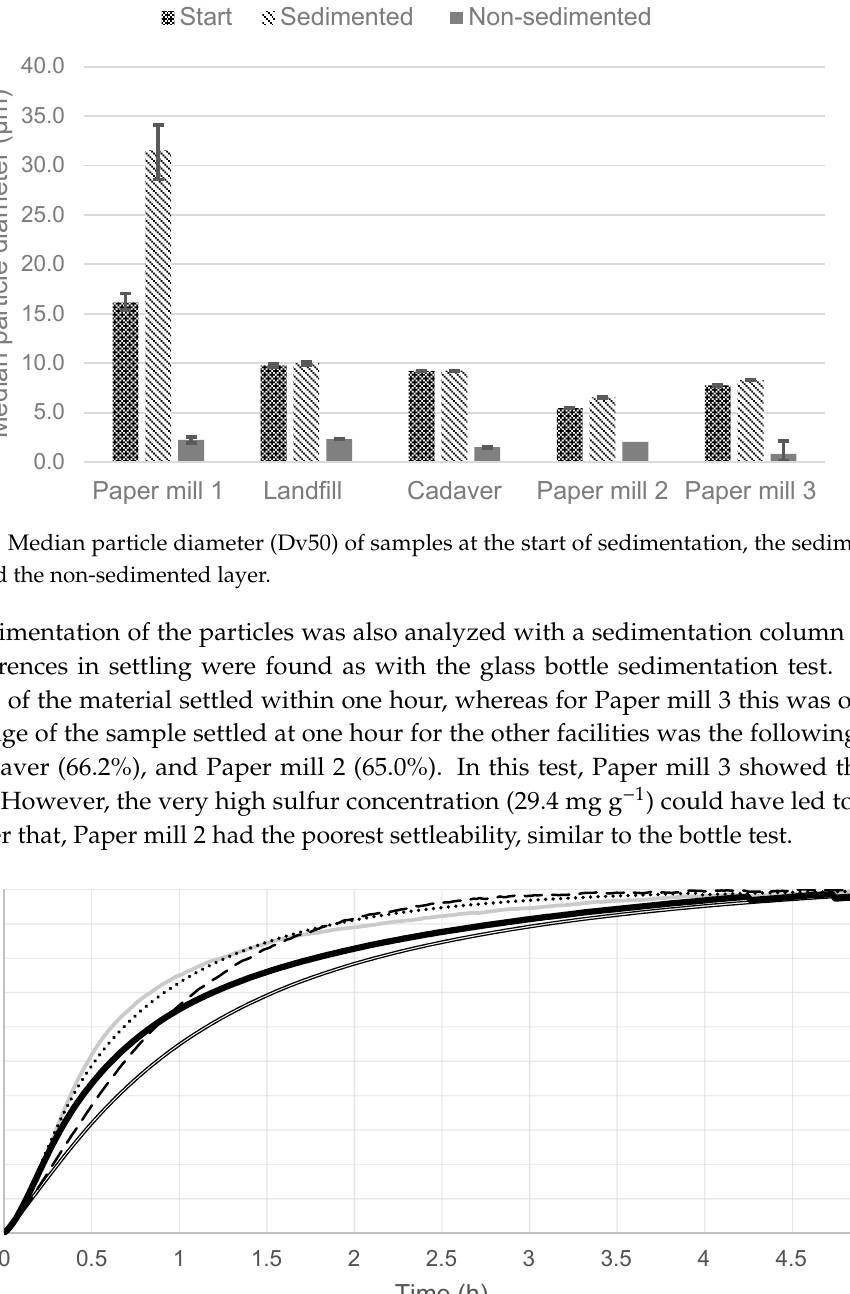
Figure 9. Sedimentation velocity at 725 × g as compared to sulfur concentration. A light trend shows that samples with high sulfur concentration have lower sedimentation velocity. 3.3. Possible Explanations for Differences in Sulfur Particle Properties We found significant differences in the particle morphology, size, and settling behavior of sulfur particles originating from a number of full-scale BD facilities. For example, sulfur particles formed in BD facility Paper mill 1 are the largest and showed the best settling properties. The aggregates found in Land fill, Cadaver, and Paper mill 3 also settled well. While the aggregates appeared the largest in the PSD, the SEM pictures indicated that those aggregates consist of a cluster of smaller particles (Figure 4). The particles in the aggregates were smaller compared to the individual particles from